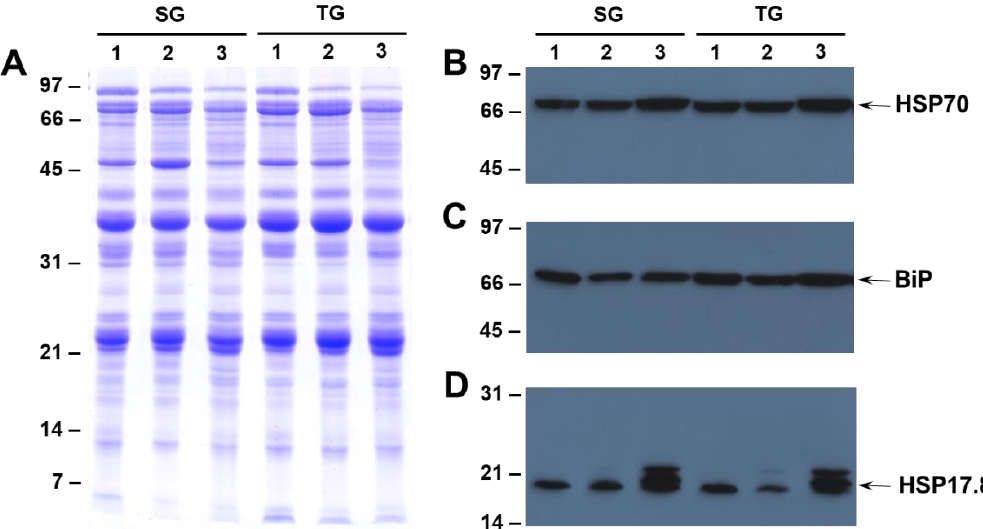
Figure 3. Immunological detection of heat shock and immunoglobulin heavy chain-binding proteins in tolerant (TG) and heat stress sensitive (SG) genotypes. Seed proteins were extracted from seeds of heat tolerant (TG) and heat-sensitive (SG) genotypes grown at di ff erent temperatures and separated by SDS-PAGE ( A ). Resolved proteins were electrophoretically transferred to nitrocellulose membranes and probed with ( B ) heat shock protein70 (HSP70); ( C ) immunoglobulin heavy chain-binding protein (BiP); and ( D ) heat shock protein17.6 (HSP17.6); specific antibodies. Immunoreactive proteins were identified using anti-rabbit IgG-horseradish peroxidase conjugate followed by chemiluminescent detection. The numbers on the left side of the figure indicate the sizes of protein standards in kilodaltons.